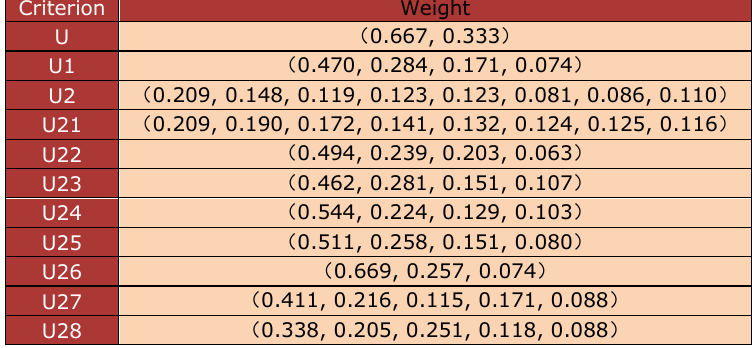
Table 5. Criteria